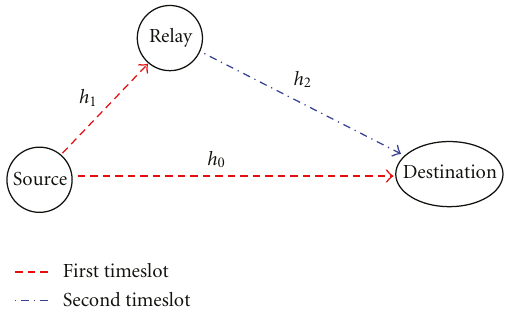
Figure 1: A relay channel consisting of half-duplex